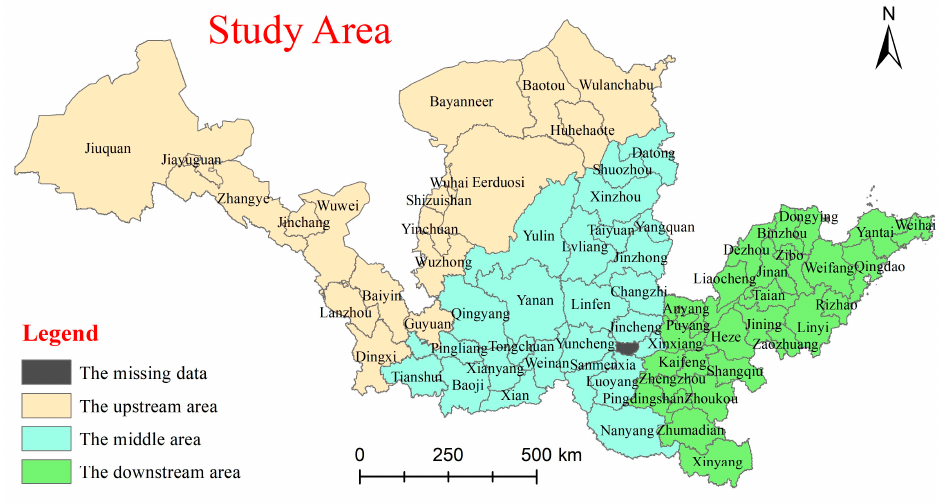
Figure 1. Study area